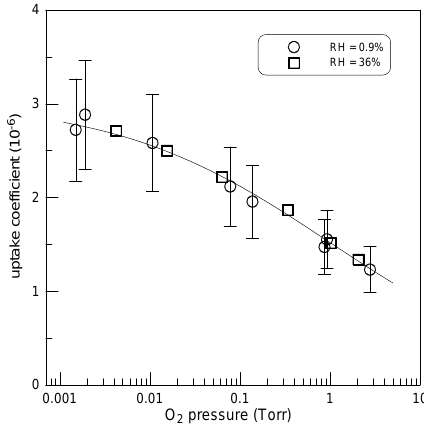
Fig. 10. Uptake coefficient as a function of partial pressure of oxygen: T =280K, P = 9Torr, J NO Figure 10.